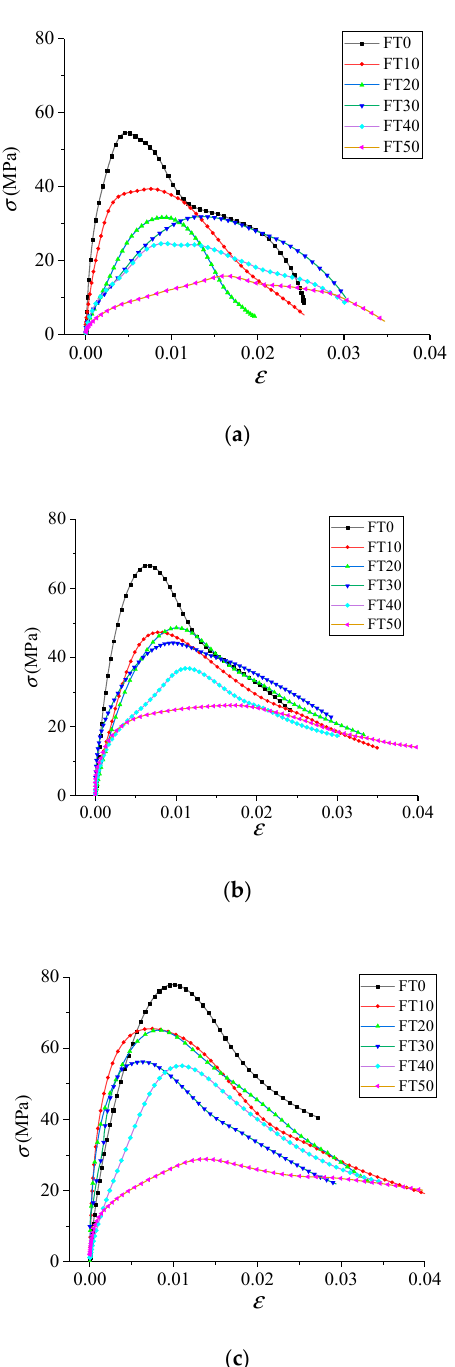
Figure 7. Dynamic stress–strain curves of freeze–thawed concrete. ( a ) 5.4 m/s; ( b ) 8.8 m/s; ( c ) 11.3 m/s.